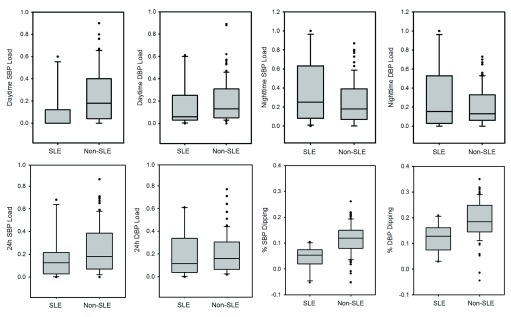
Attenuated BP dipping and trends toward less daytime and more nighttime HTN in pediatric SLE.Box plots indicate median, 10th, 25th, 75th, and 90th percentile data, based on Wilcoxon Analysis. Dots indicate the outliers. Differences in %SBP dipping (
p = 0.001) and %DBP dipping (
p = 0.003) and daytime SBP load (
p = 0.01) were statistically significant whereas differences in nighttime SBP load (
p = 0.36) and DBP load (
p = 0.59) failed to reach significance.